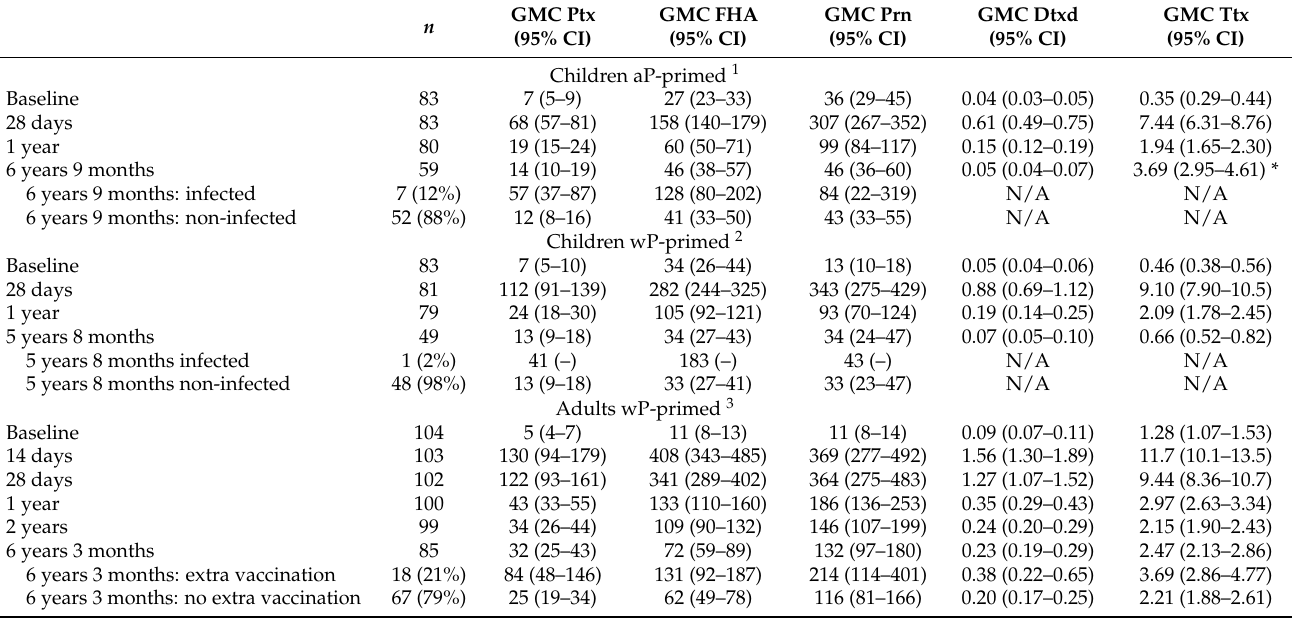
Table 1. Geometric mean concentrations calculated per cohort per